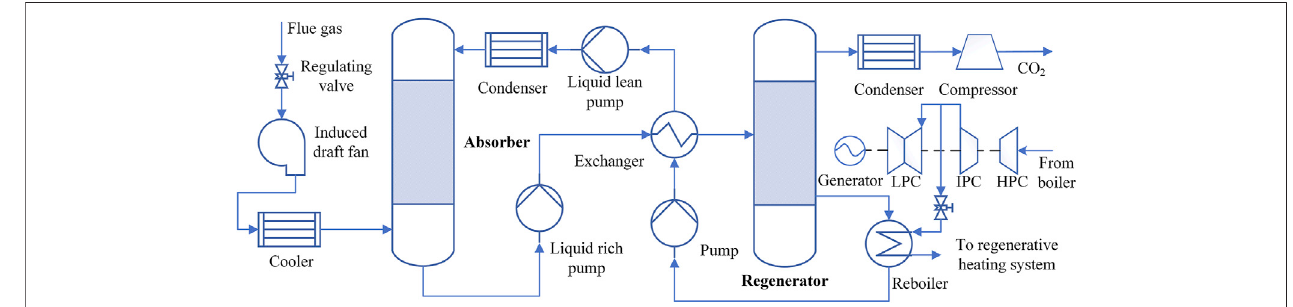
FIGURE 1 | Simpli fi ed scheme of